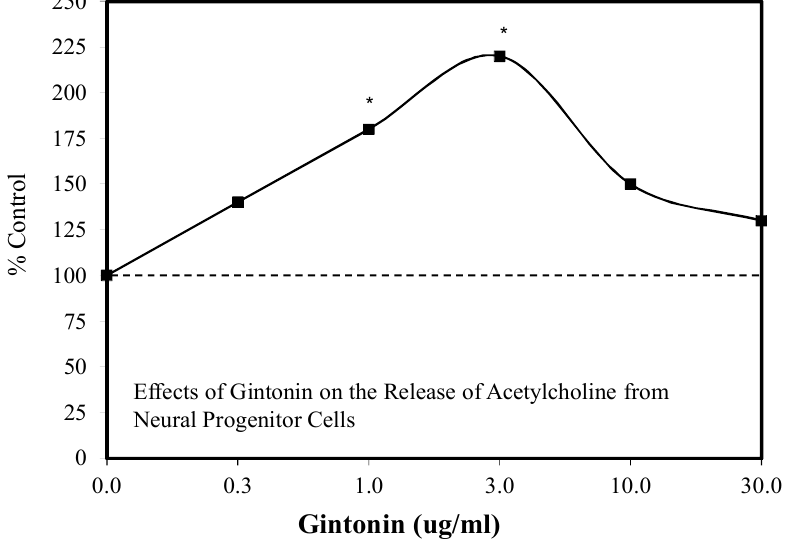
Figure 41. Effects of gintonin on the release of acetylcholine from neural progenitor cells (source: [129,131]). Each * represent statistical significance for a data point.